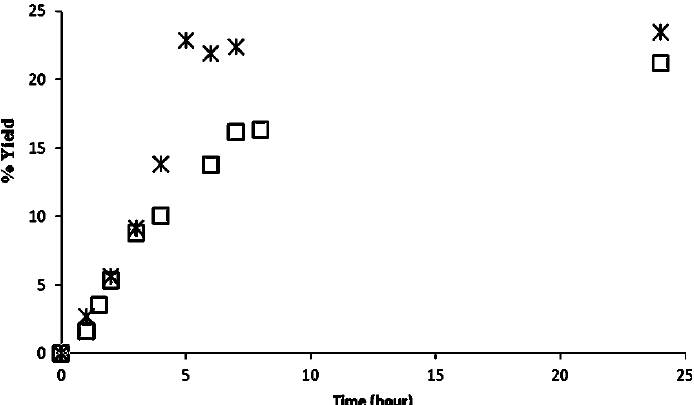
Figure 5. Reaction profiles (24 h) of transesterification of triolein using a 1:1 molar ratio of oil and methanol (30 °C). CaL-S (star) and CaL-M (square). The maximum theoretical yield is